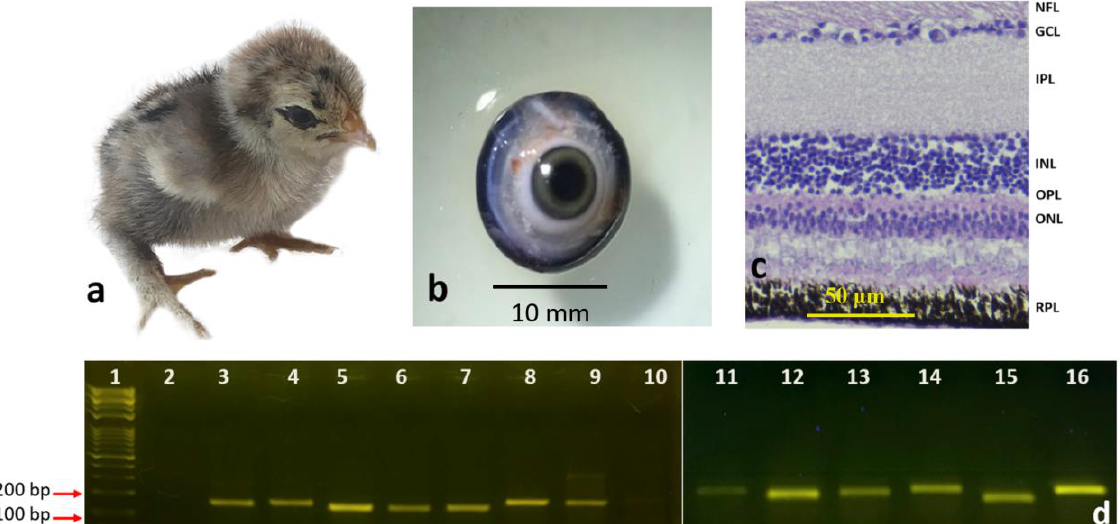
Figure 3. Newly hatched chick: ( a ) whole chick, ( b ) the retrieved eye, ( c ) cross section of the retina